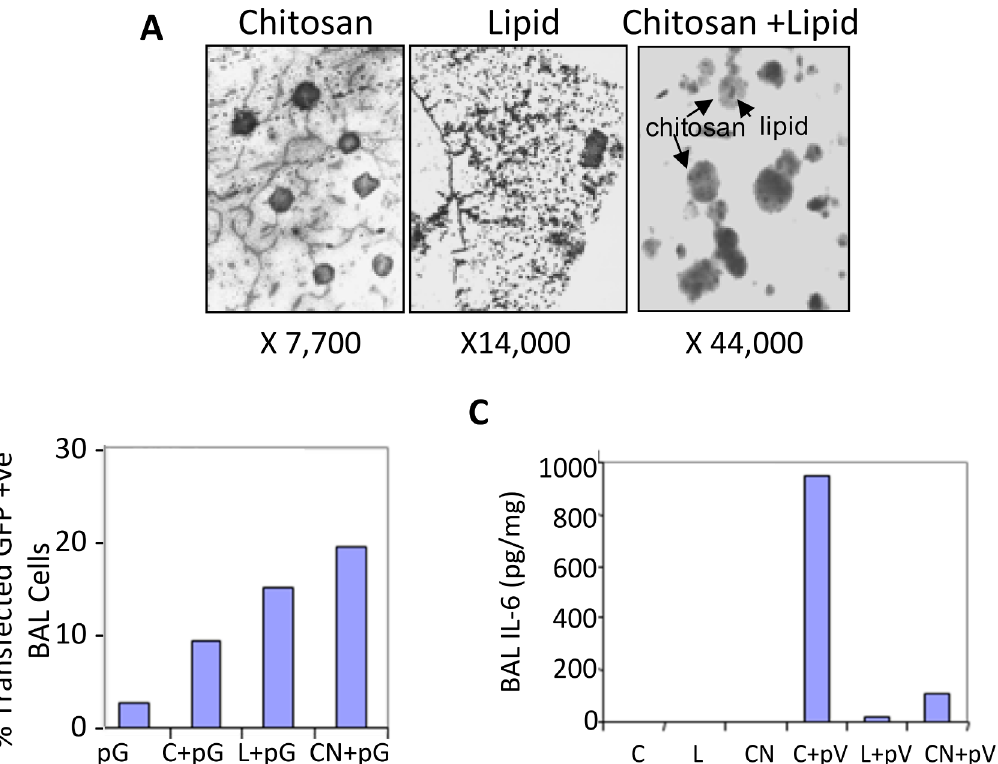
Fig 1. Efficacy and safety of chlipids. (A) Transmission electron micrographs of chitosan, Lipofectamine and CNs complexed with pEGFP. (B) Distribution and quantification of in vivo transfection of pEGFP in BAL cells of C57/BL6 mice. pG: Naked EGFP plasmid; C+pG: chitosan-complexed pG; L+pG: Lipofectamine-complexed pG; CN+pG: chlipid-complexed pG. (C) Quantification of IL-6 in BAL following intranasal administration of nanoparticles. C: chitosan; L: Lipofectamine; CN: chlipid; C+pV: chitosan-complexed pVAX DNA; L+pV: Lipofectamine-complexed pVAX DNA; and CN+pV: chlipid- complexed pVAX